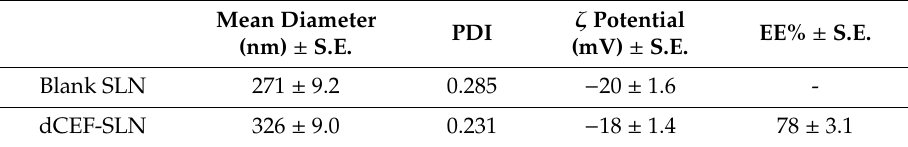
Table 3. Physicochemical characteristics of blank SLN or dCEF-loaded